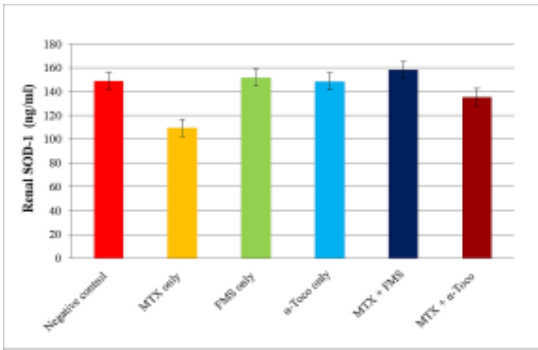
Figure 3.Effects of fimasartan on the renal MDA levels .